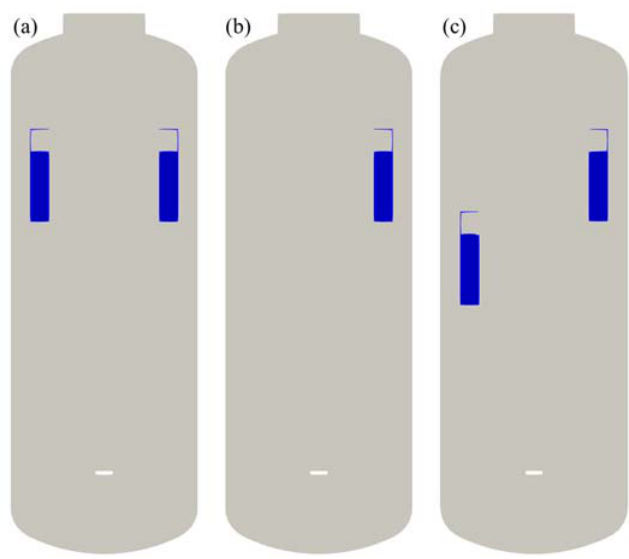
Figure 6. PAR configurations for the SAPRC ‐ PAR experiment. ( a ) 2 PARs in parallel; ( b ) 1 PAR; ( c ) 2 PARs staggered.